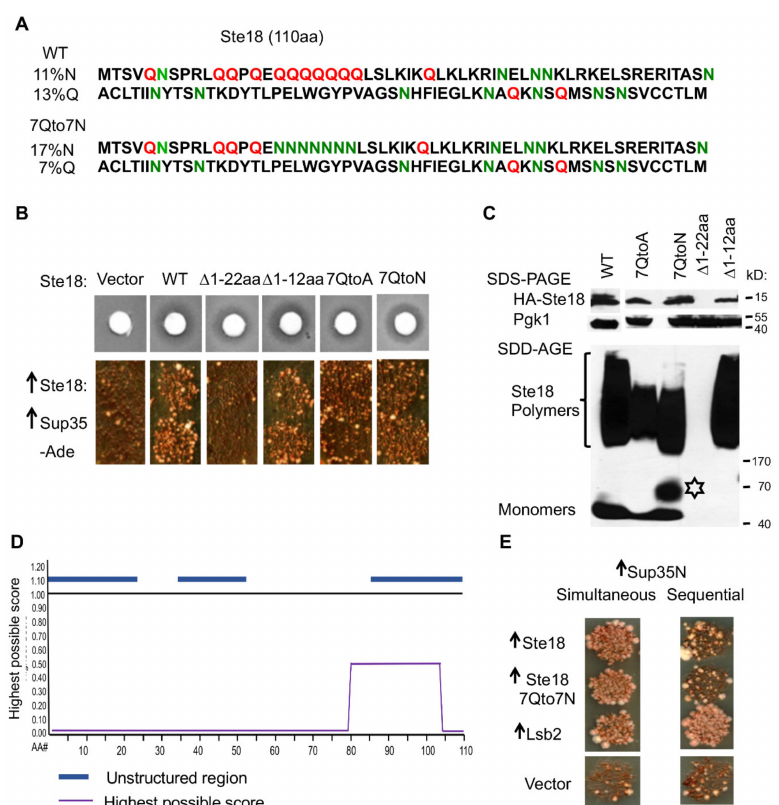
Figure 2. The intrinsically disordered N-proximal region of Ste18 is not essential for its prion-inducing ability. ( A ) Sequences of the wild-type Ste18 protein and its 7Qto7N variant. ( B , C ) Substitutions 7Qto7N or 7Qto 7A, or deletion of the first 12 aa residues of Ste18 ( ∆ 1–12) do not abolish pheromone sensitivity ( B ), [ PSI + ] nucleation ( B ) and formation of detergent resistant aggregates ( C ). Deletion of the first 22 aa residues of Ste18 ( ∆ 1–22) abolishes [ PSI + ] nucleation ( B ) and polymer formation ( C